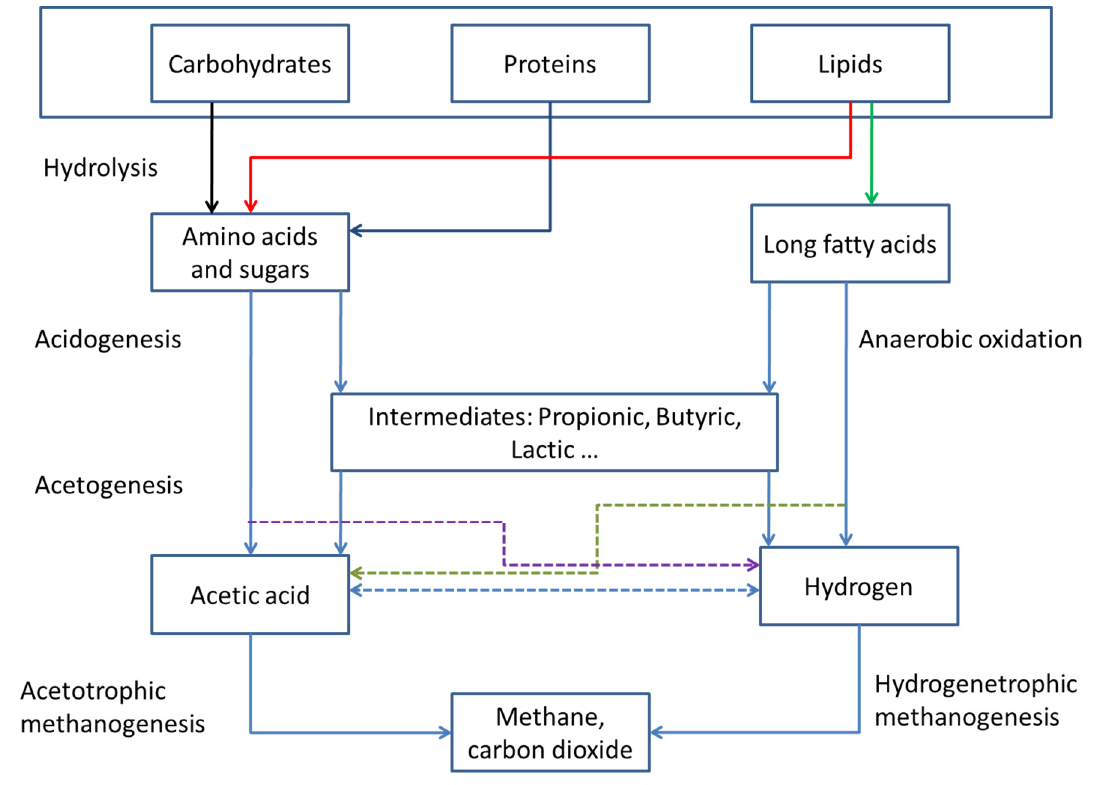
Figure 3. Anaerobic digestion was adapted from Bajpai [50] and Khanal [51].